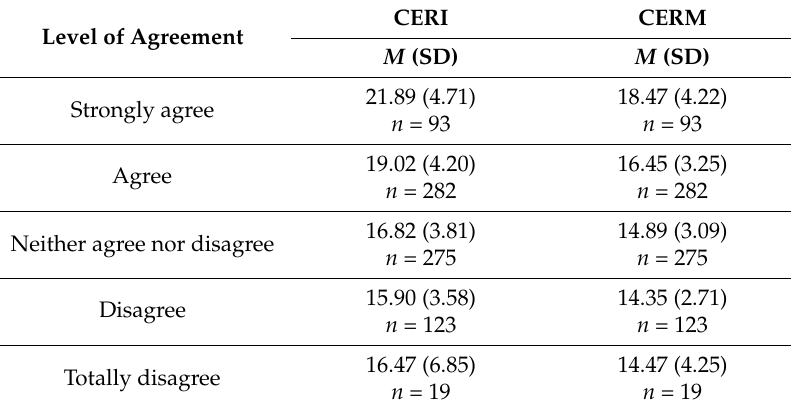
Table 4. Levels of agreement with the statement “I am addicted to the Internet” with the scores in CERI and